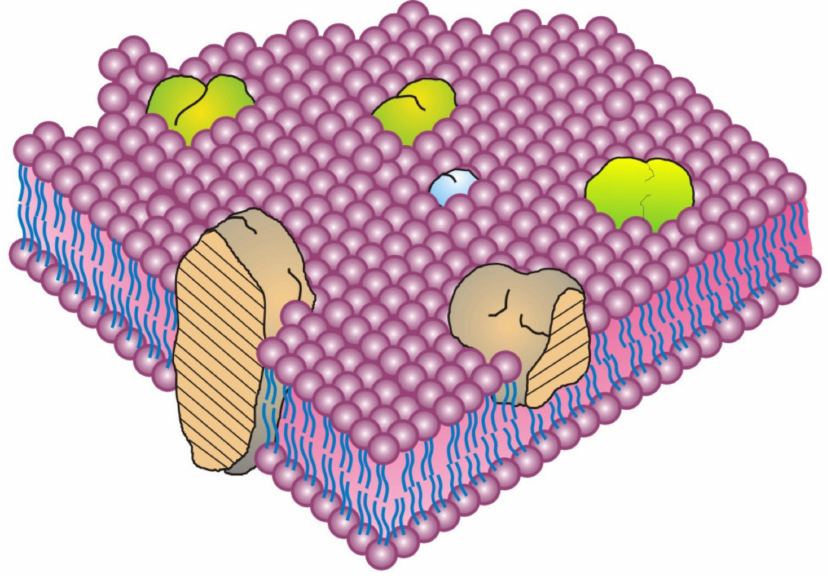
Figure 1. The Singer–Nicolson Fluid–Mosaic Membrane Model of cell membrane structure as proposed in 1972. In this static view of a fluid cell membrane, the solid bodies with stippled cut surfaces represent globular integral membrane proteins randomly distributed in the plane of the membrane. Some integral membrane proteins form specific integral protein complexes, as shown in the figure. Integral proteins are represented as intercalated into a fluid lipid bilayer, but peripheral membrane proteins are mentioned but not shown, nor are tightly-bound lipids. Further, the figure does not contain other membrane-associated structures or membrane domains (Redrawn from Singer and Nicolson